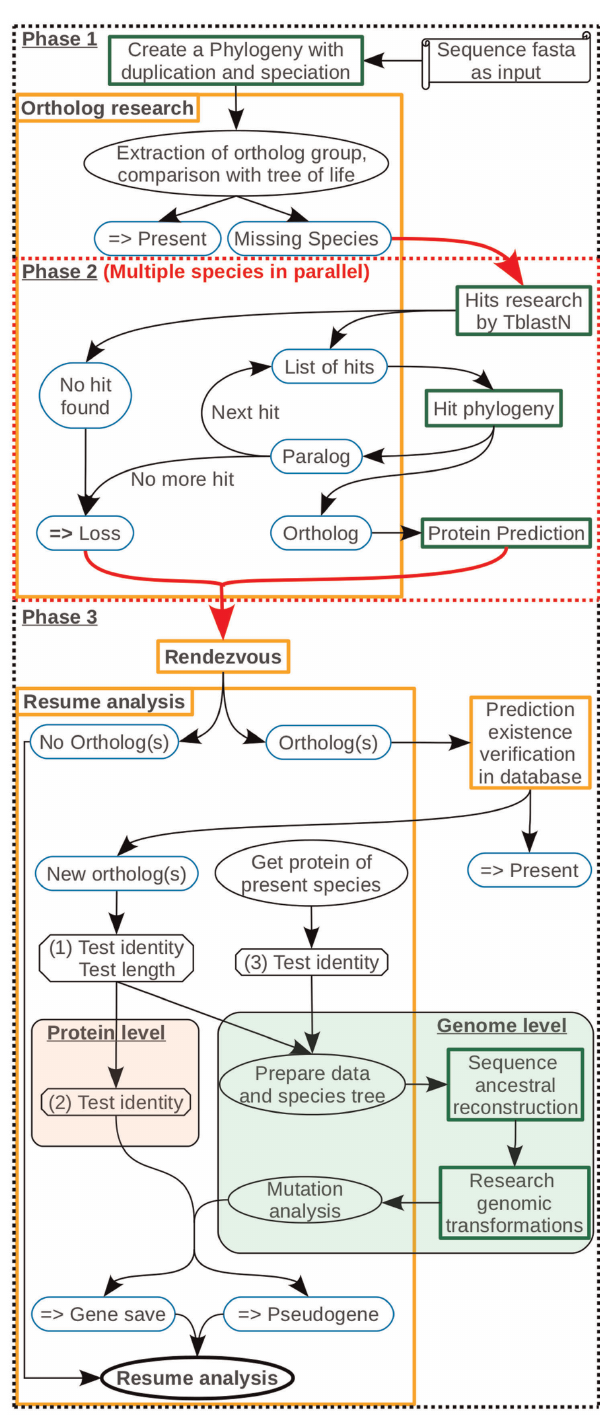
Figure 2. Method for identifying lineage-specific gene losses and pseudogenes. Parchment illustrates the necessary data for starting a study. Rectangles correspond to agents with their descrip- tions. The agents launching pipelines are in the green frame. Blue round-edge rectangles highlight essential results. Those with horizontal double arrows are final conclusions. Ellipses are a state or an action. Octagons consist in tests or analyses necessary to define the follow-up on the study. Arrows show the study pathway. Phase 1: Detection of species in which orthologs are missing. Phase 2: Parallel studies screening each orthologous sequence for each missing species. Phase 3: The red arrow is a factorization of the different species studied.